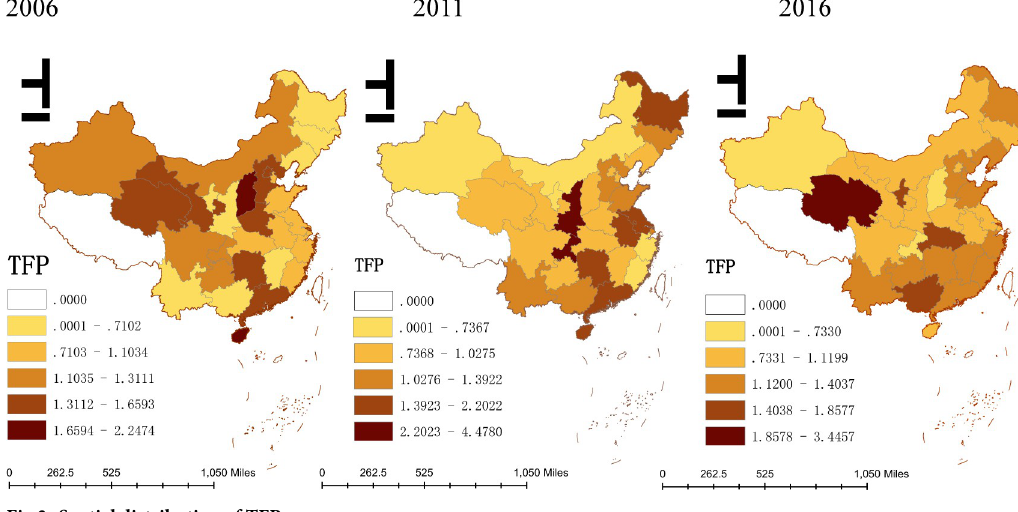
Fig 3. Spatial distribution of TFP.